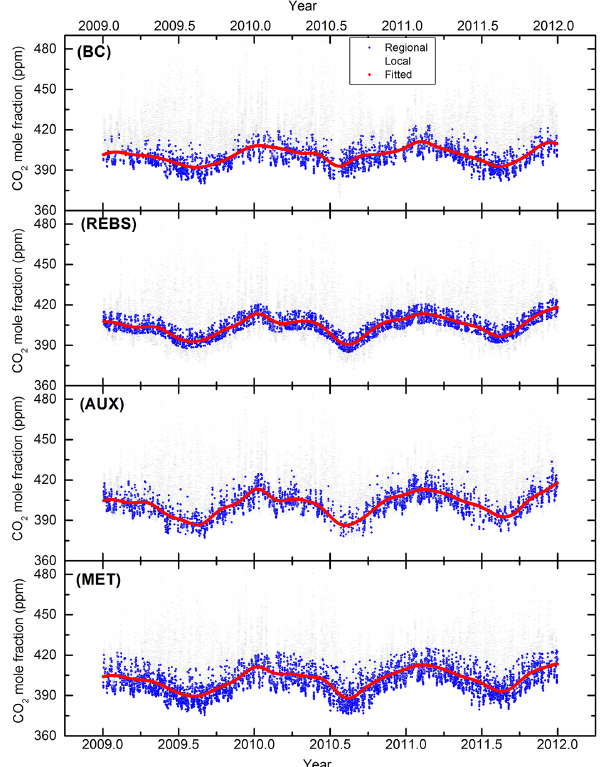
Figure 4. Filtered CO 2 mole fractions in the four approaches (BC: black carbon as tracer; REBS: Robust Extraction of Baseline Sig- nal; AUX: CH 4 as auxiliary tracer; MET: meteorological filter). The closed blue circles represent the filtered regional events. The open gray circles represent local events which are influenced by very local sources or sinks. The red lines are results fitted to the fil- tered regional events using the curve-fitting method by Thoning et al.